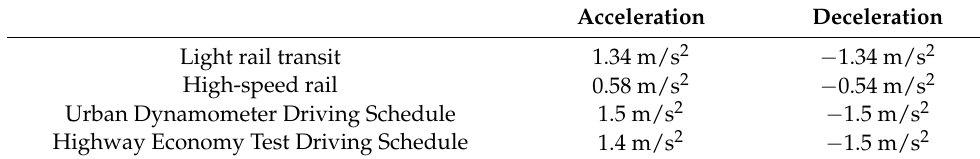
Table 1. Reference standards for acceleration and